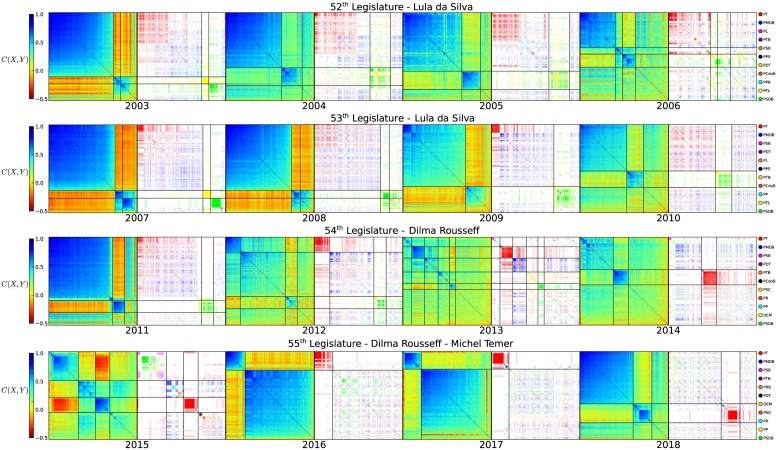
MST reordered correlation and party matrices for the 52th, 53th, 54th and 55th Legislatures.In each panel, in the left we present the MST-prim reordered correlation matrices colored by the correlation values, and on the right the same matrix colored by the party. We maintain the same color for the parties throughout all Legislatures. The MST ordering process can be used to detect strong anomalies in the Representatives’ system.